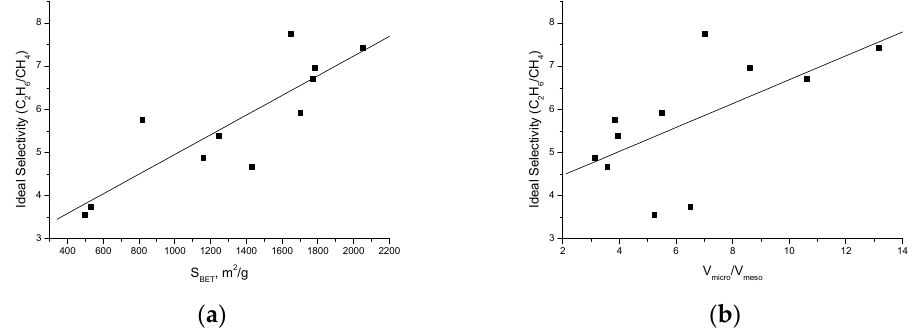
Figure 5. The pressure dependencies of C 2 H 6 /CH 4 ideal and IAST selectivities at 298 K for the 1solv , 5mw and 8solv samples.